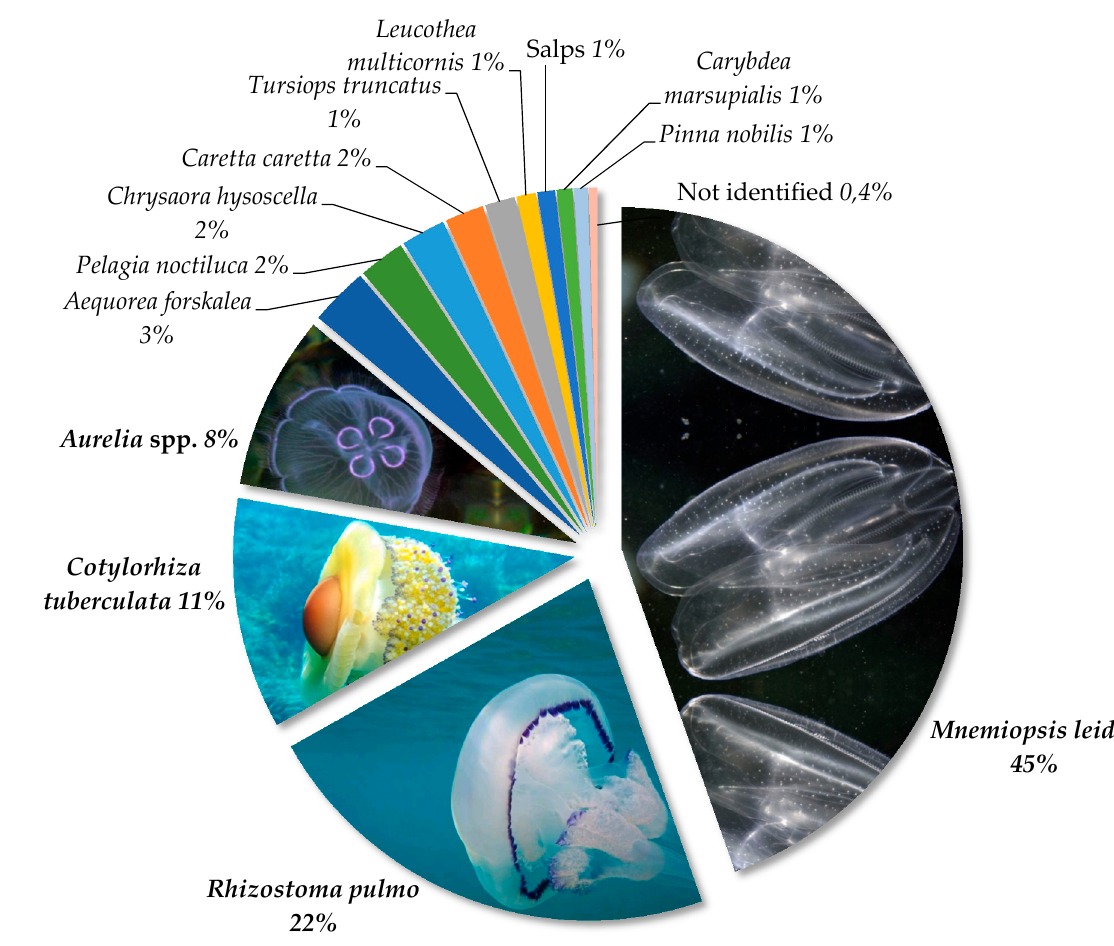
Figure 5. Reported taxa with avvistAPP from 12 July 2019 to 8 March 2021. Total sightings: 1188.